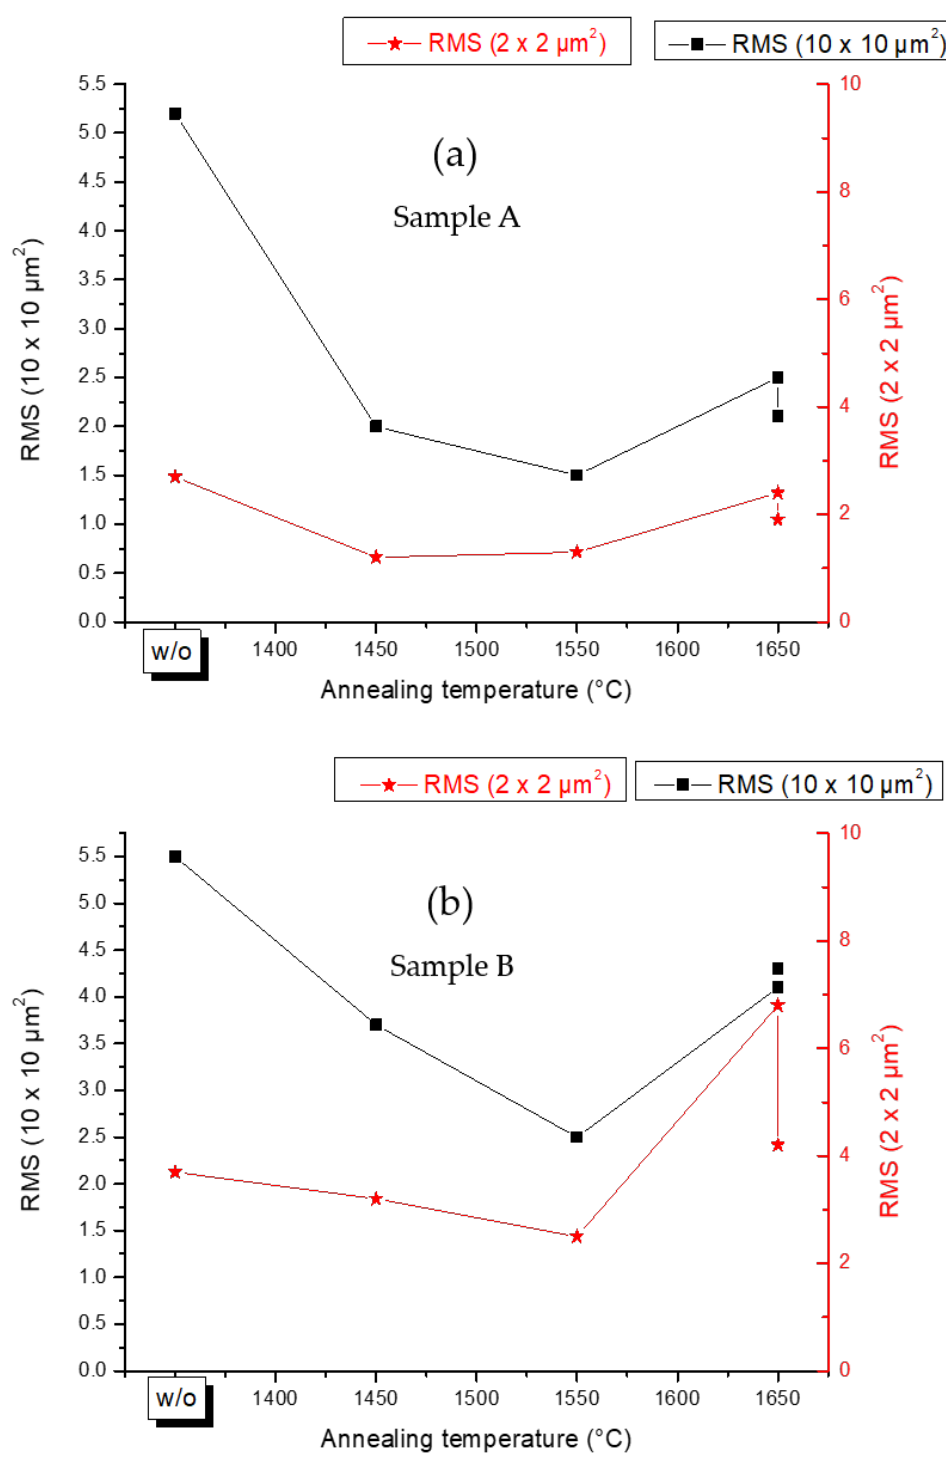
Figure 4. Variation of the RMS roughness as a function of the annealing temperatures for ( a ) sample A and ( b ) sample B. The RMS values are measured on (10 × 10) µm 2 atomic force microscopy topo- graphic images.